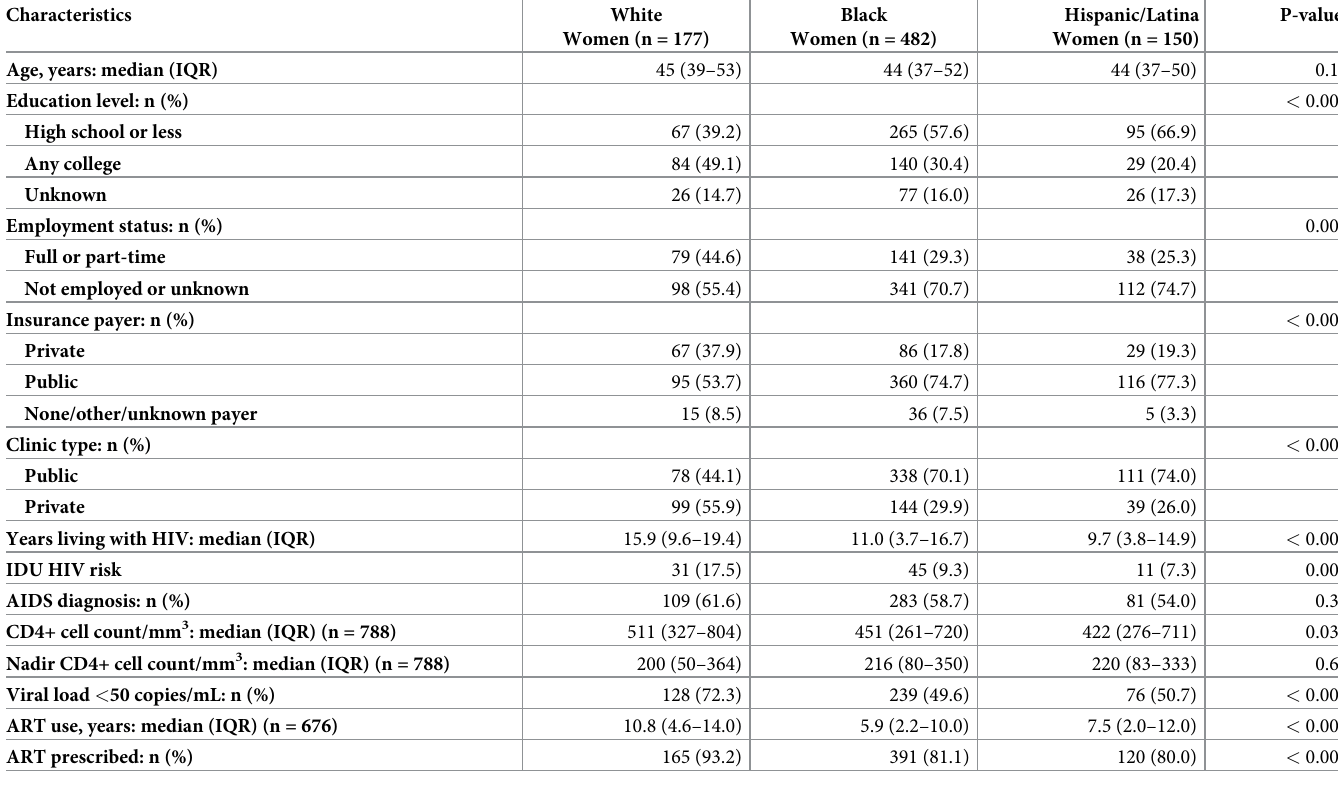
†Table includes baseline data only (at HOPS study